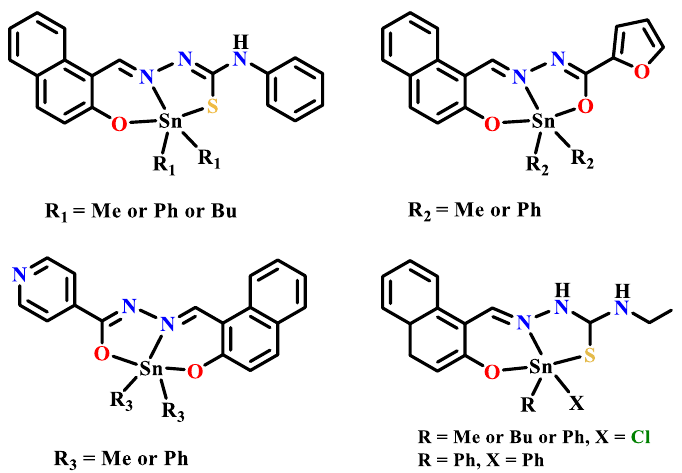
Figure 13. A series of mononuclear organotin(IV) complexes of